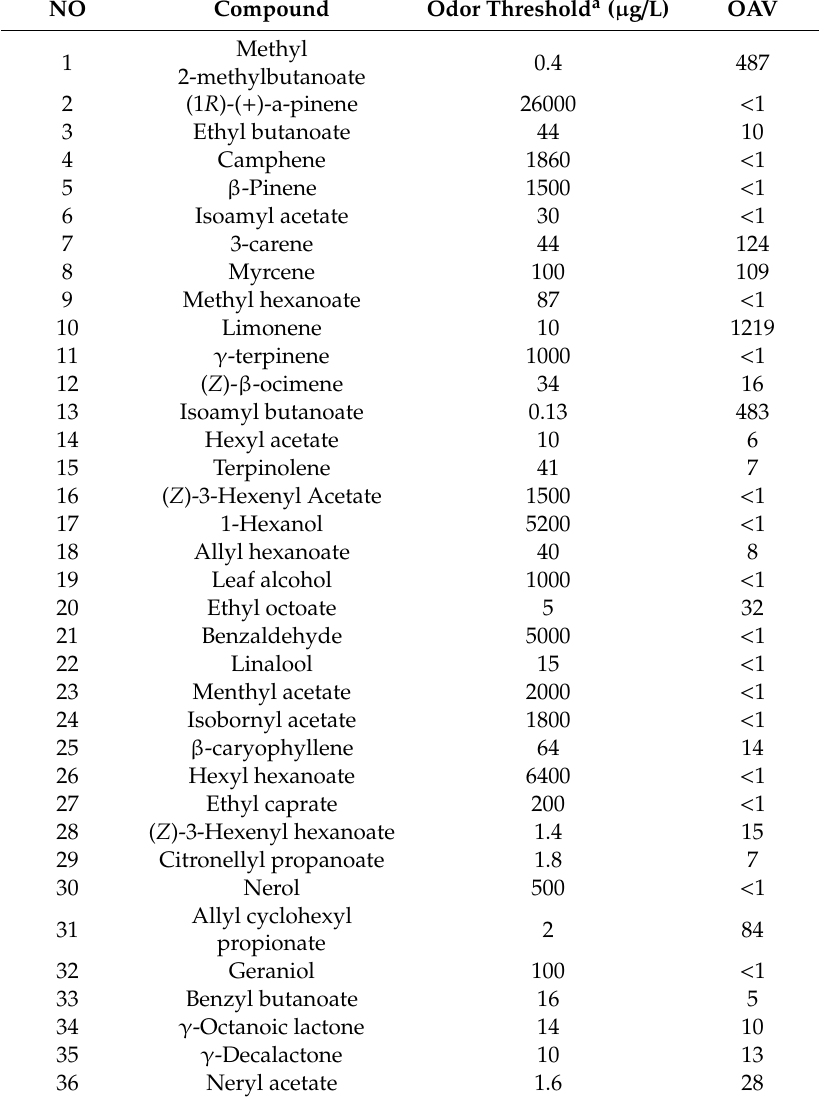
Table 3. OAV (odor activity value) of the volatile compound in mango and vodka